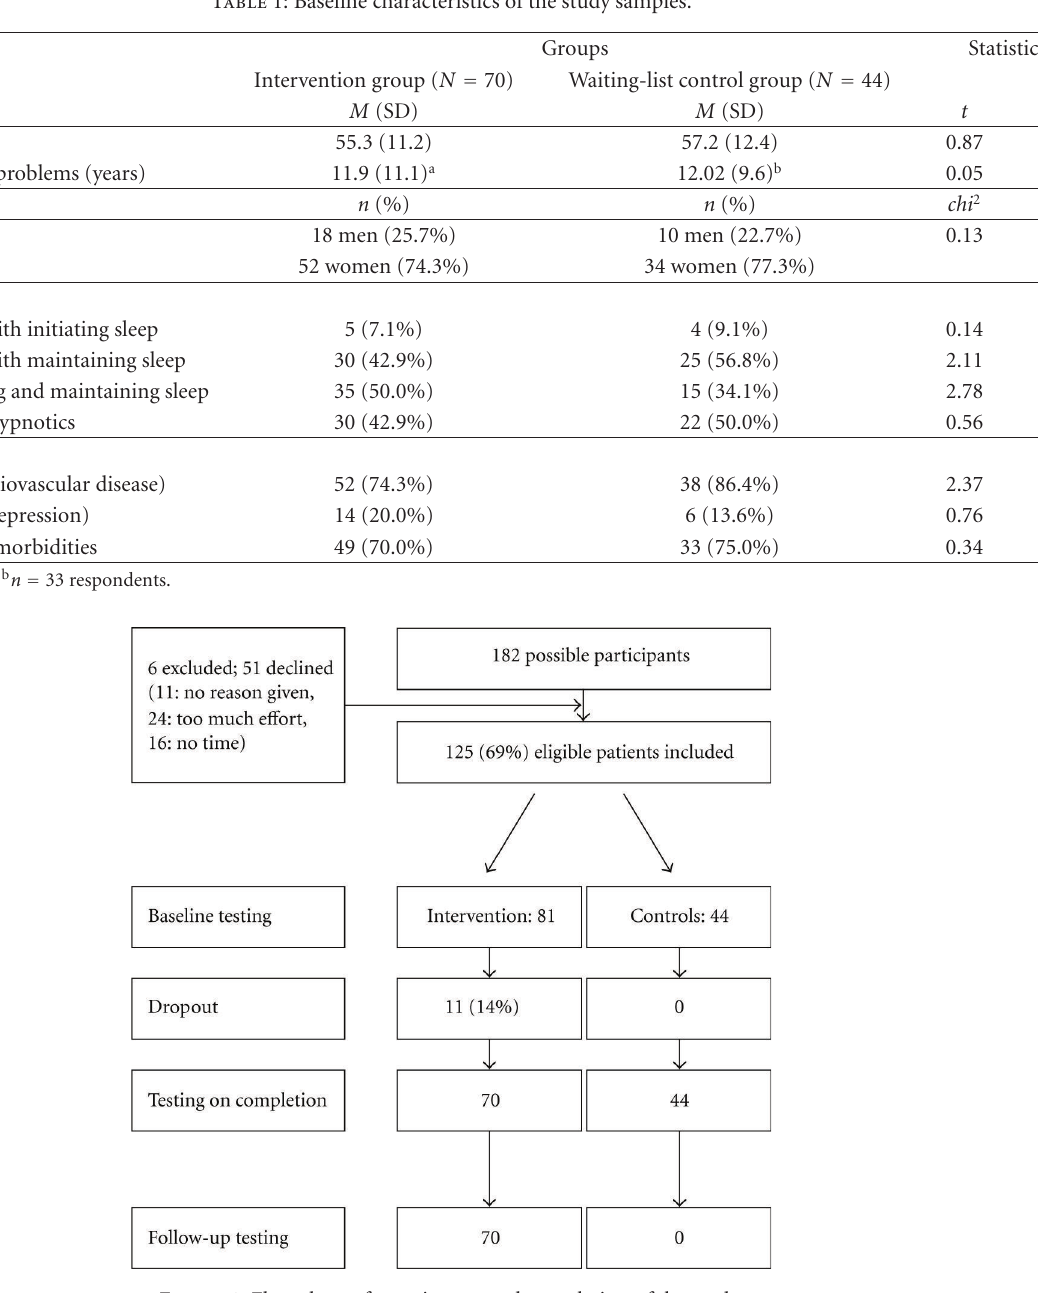
Figure 1: Flow chart of recruitment and completion of the